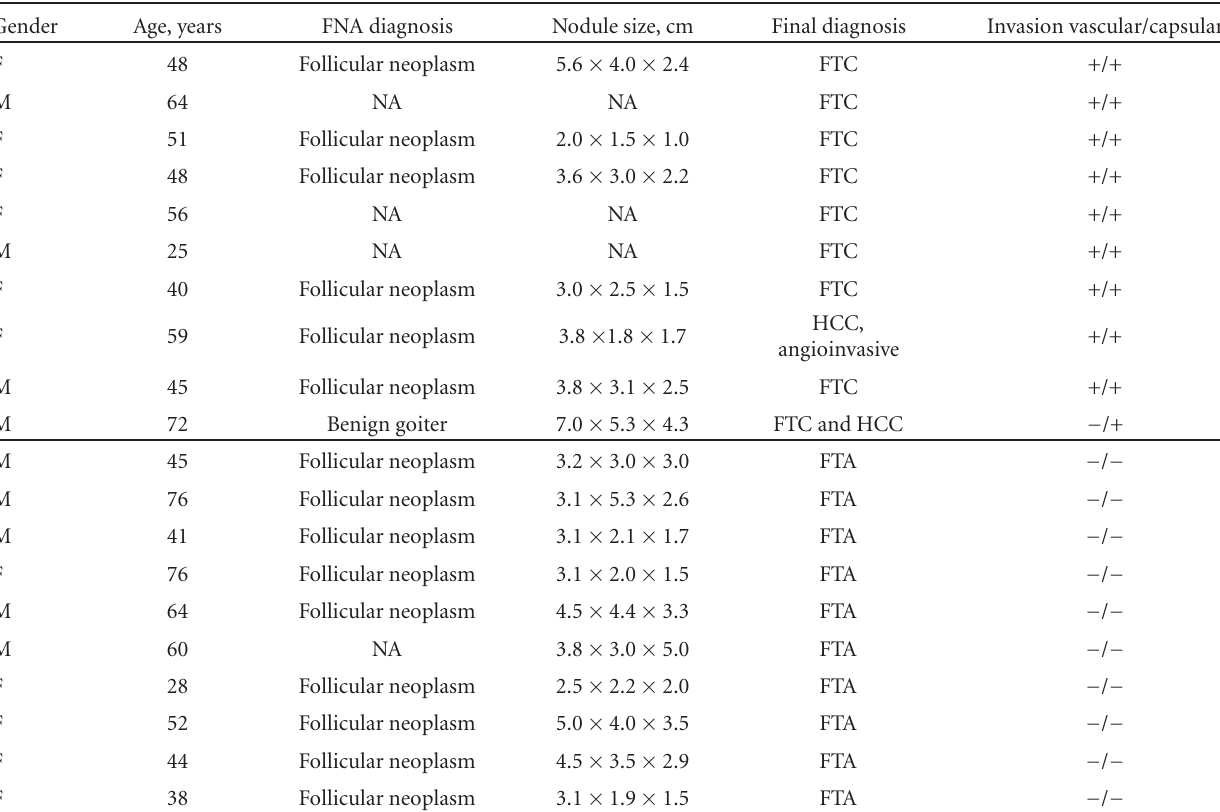
Table 1: Clinical data of patients from whom follicular thyroid tumor tissue samples were collected.